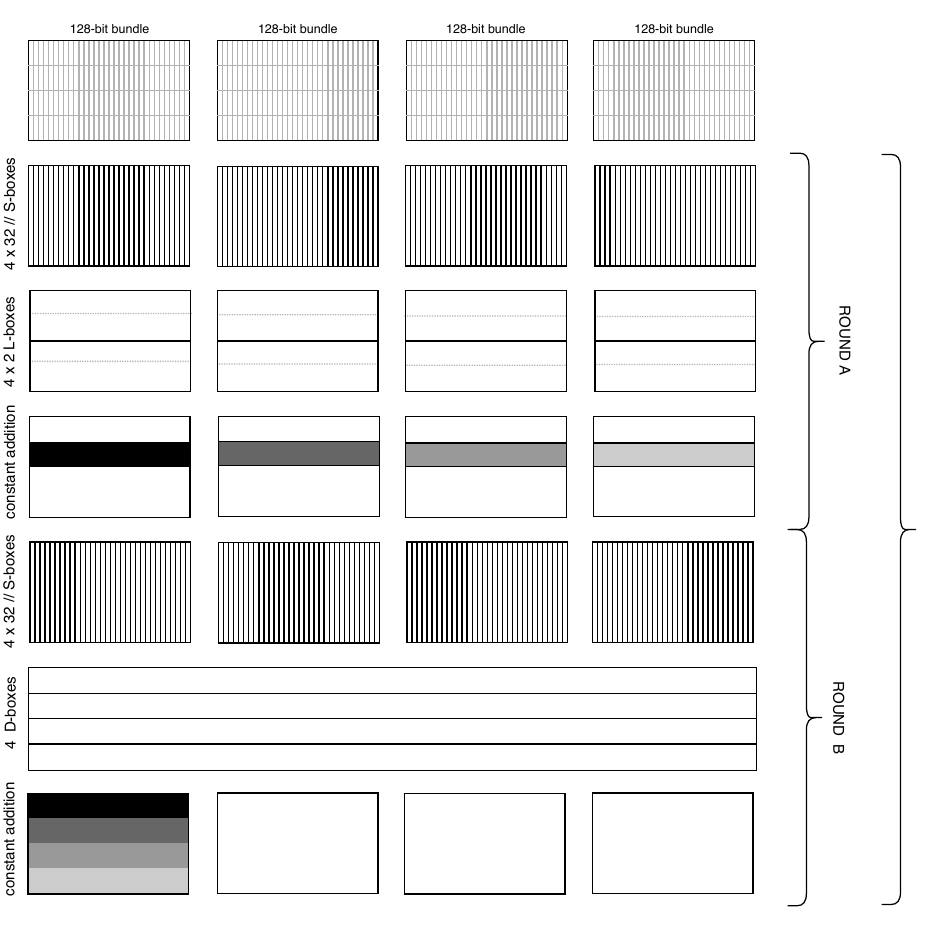
Figure 11: Round and step of Shadow-512 v2 : high-level